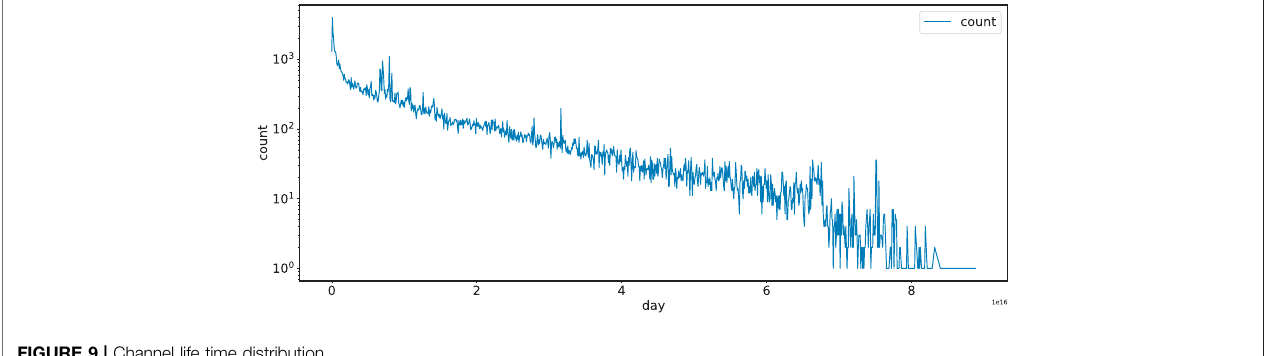
FIGURE 9 | Channel life time